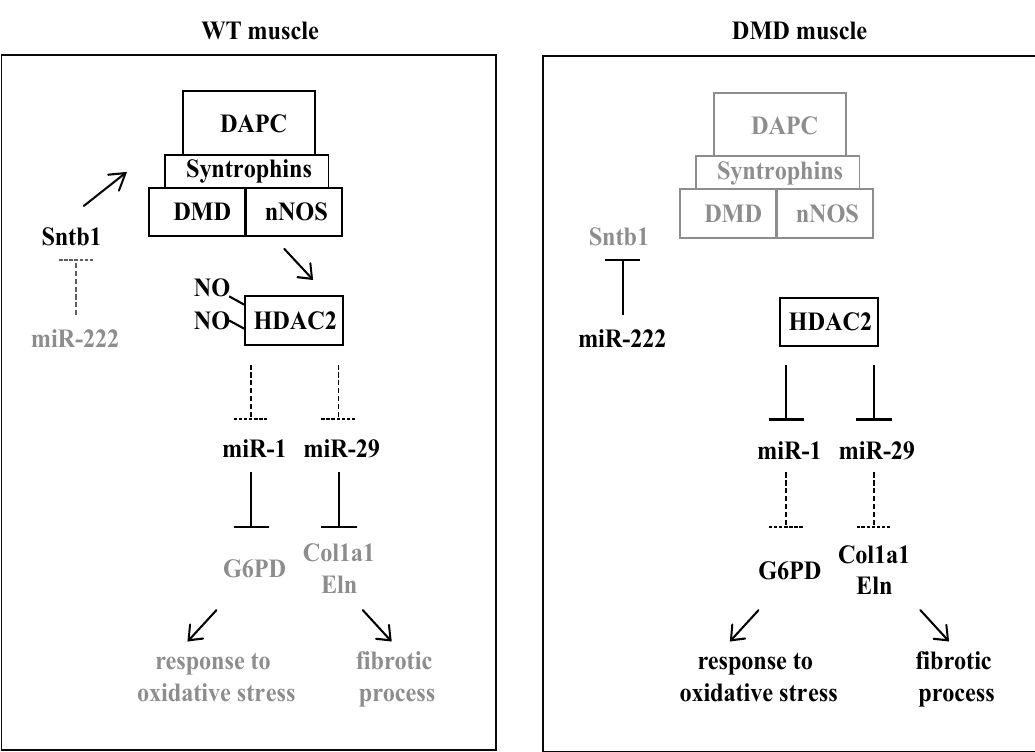
Figure 2. Schematic representation of the functional/physical relationship between Dystrophin-Syntrophins-nNOS pathway and miRNAs involved in such signaling, both in a WT and a DMD